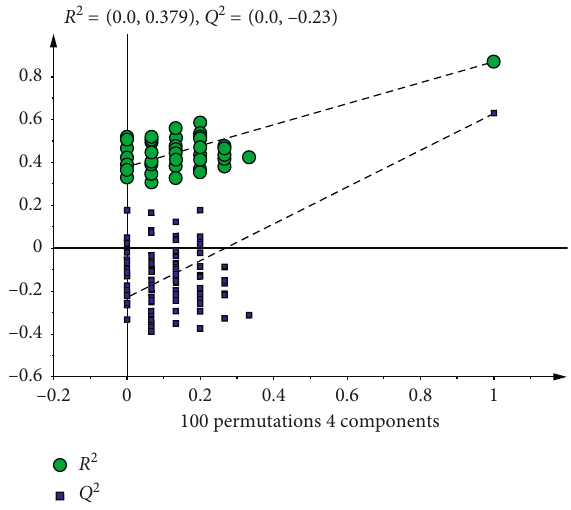
Figure 4: The PLS-DA replacement test Table 2: The difference metabolites of rice in two origins.